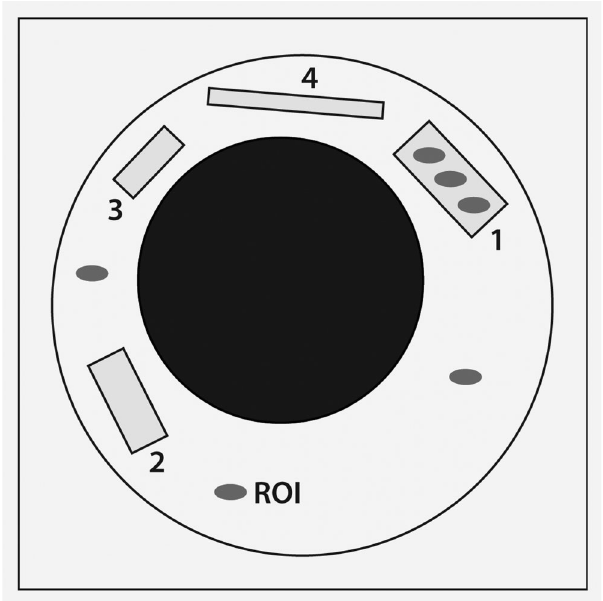
Figure 3 - Signal-to-noise ratio (SNR) calculation using MR images of phantoms 1-4 embedded in a saline bath. SNR was calculated as SNR=0.65*(signal intensity/standard deviation), employing a correction factor of 0.65 for background noise. The grey ovals represent 1-mm 2 regions of interest